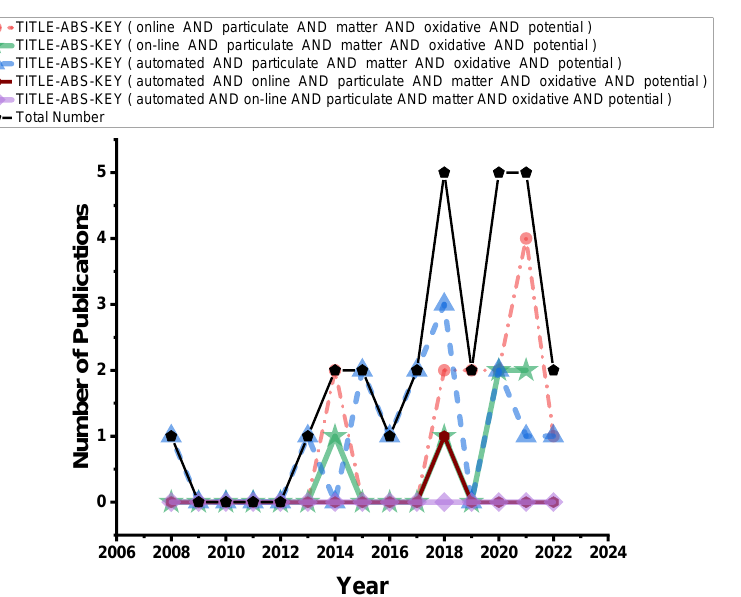
Figure 1. Graphic result of Scopus literature research, using different keyword combinations. The total number of articles (black curve) has been calculated removing duplicated articles.